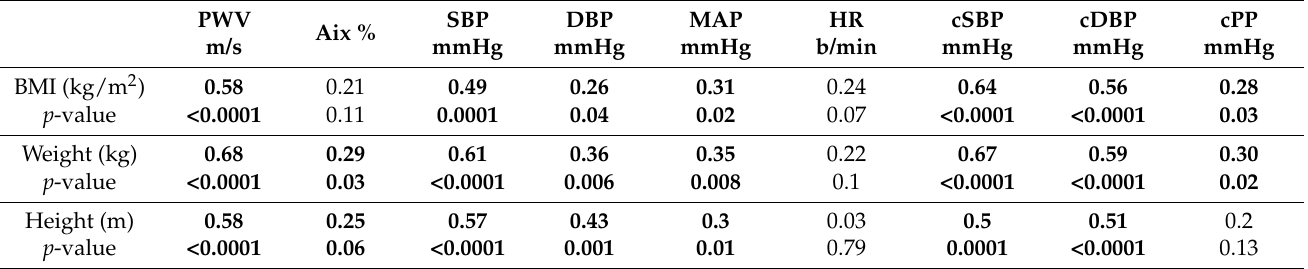
Table 3. Correlations between each PWA parameter and BMI, weight and height, respectively, in all children ( n = 55).